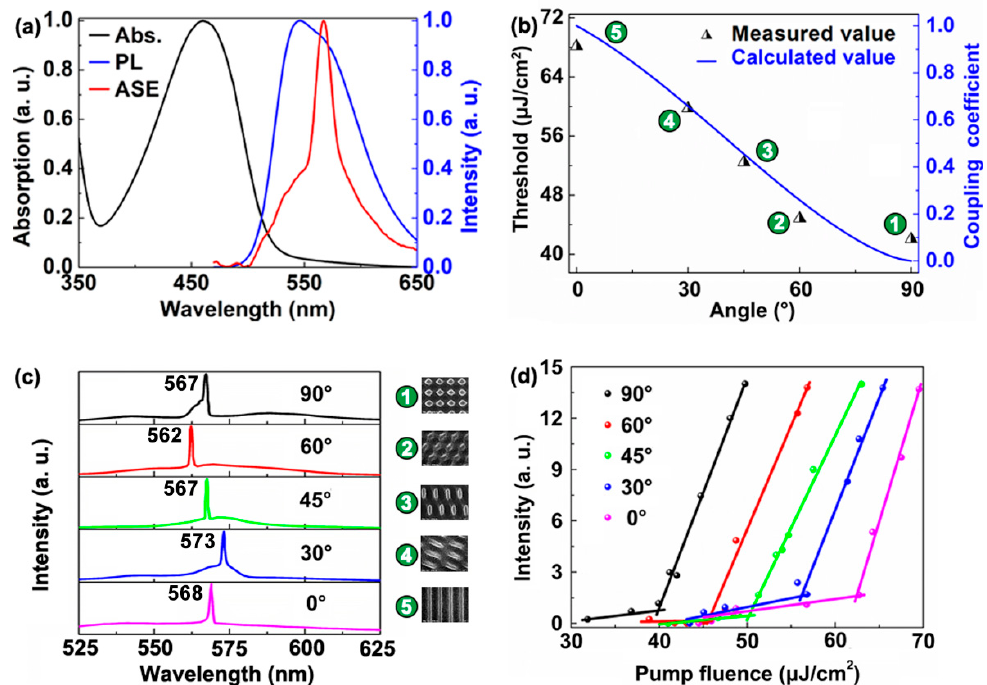
Figure 4. ( a ) Absorption, photoluminescence (PL), and amplified spontaneous emission spectra of F8BT. ( b ) Relationship between the coupling coefficient and the threshold of the 2D DFB cavity. The triangles indicate the average threshold for different 2D DFB polymer lasers. ( c ) Measured spectra of 2D DFB polymer lasers. ( d ) Output intensity of 2D DFB polymer lasers as a function of the pump fluence.